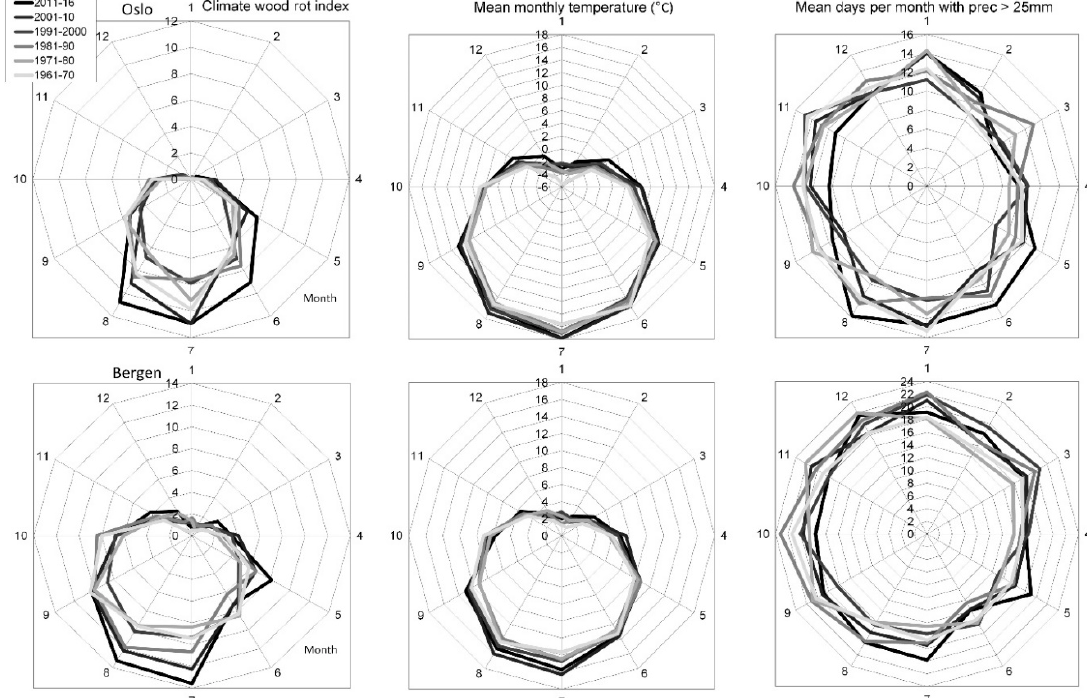
Figure 4. The change in the average values for the monthly climate index, mean temperature, and number of days with precipitation over 0.25 mm for the decades after 1961, ending with the period from 2011 through to September 2016, in Oslo and Bergen.